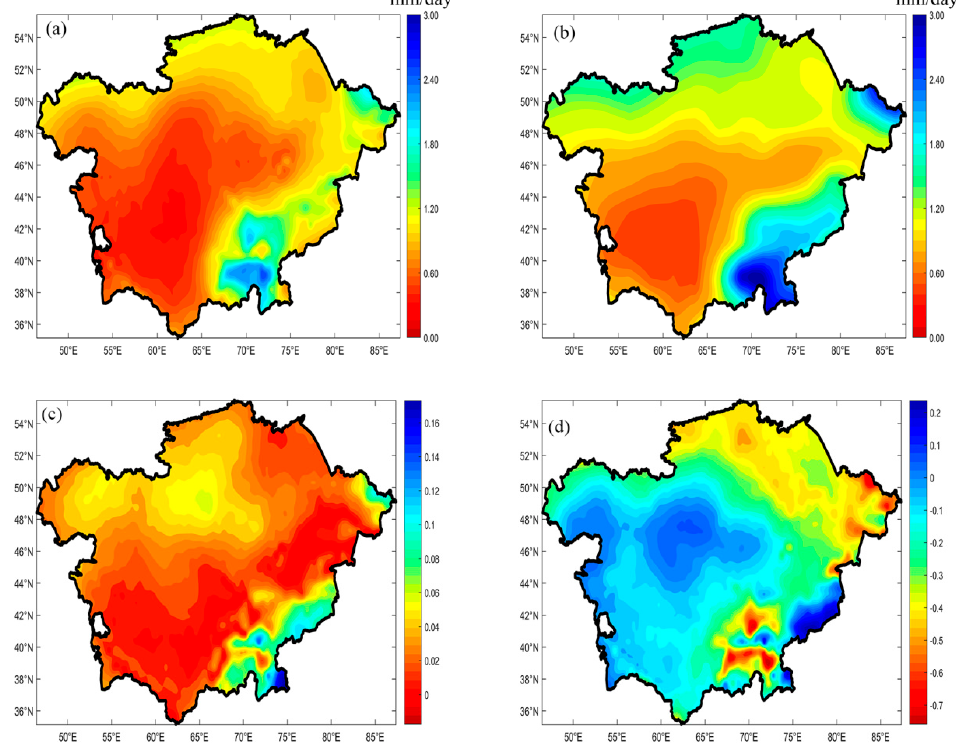
Figure 2. Spatial distribution characteristics of precipitation in 1986–2005. ( a ) Precipitation from Climate Research Unit (CRU); ( b ) precipitation from Coupled Model Intercomparison Project Phase 5 (CMIP5) Multi-Model Ensemble (MME); ( c ) root mean square error (RMSE) between CMIP5 MME and CRU in Central Asia from 1986 to 2005; ( d ) the differences of standard deviation between CMIP5 MME and CRU in Central Asia from 1986 to 2005 (MME minus CRU).